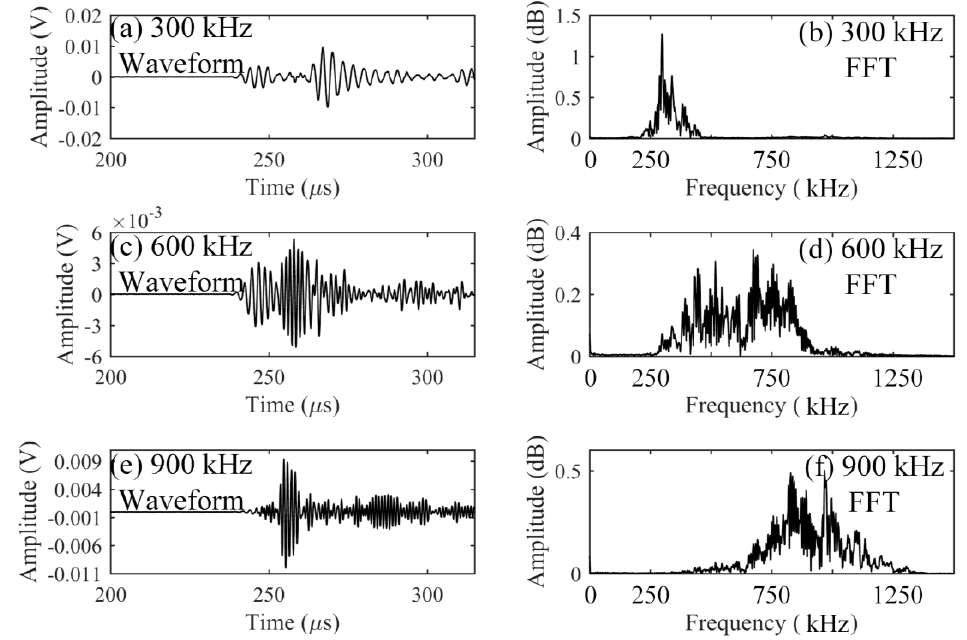
Figure 7. Ultrasonic detections at the temperature of 1100 °C with a duration of 8 h.